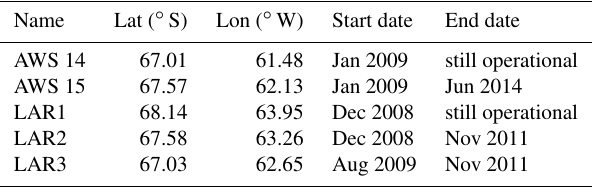
Table 1. Overview of sonic height rangers operated over the LCIS and used in this study. Locations are shown on the map in Fig.